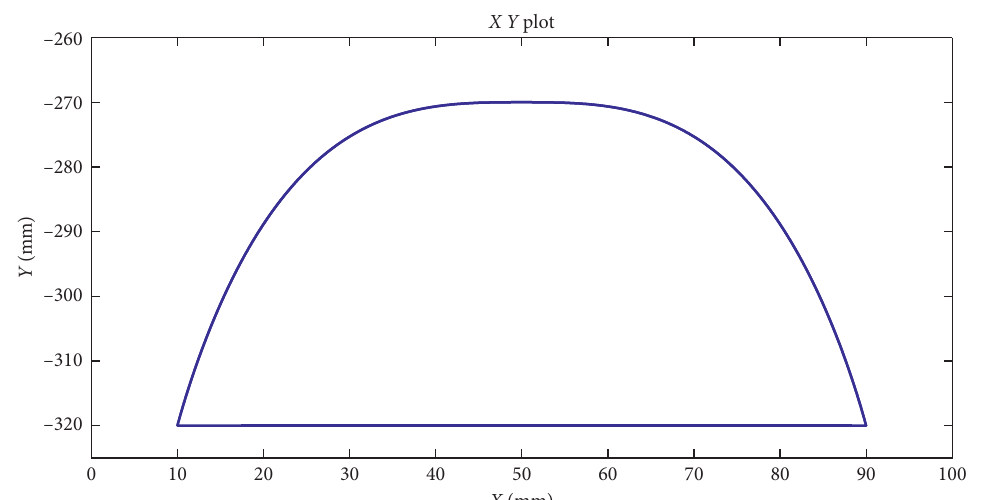
Figure 10: Trajectory curve of